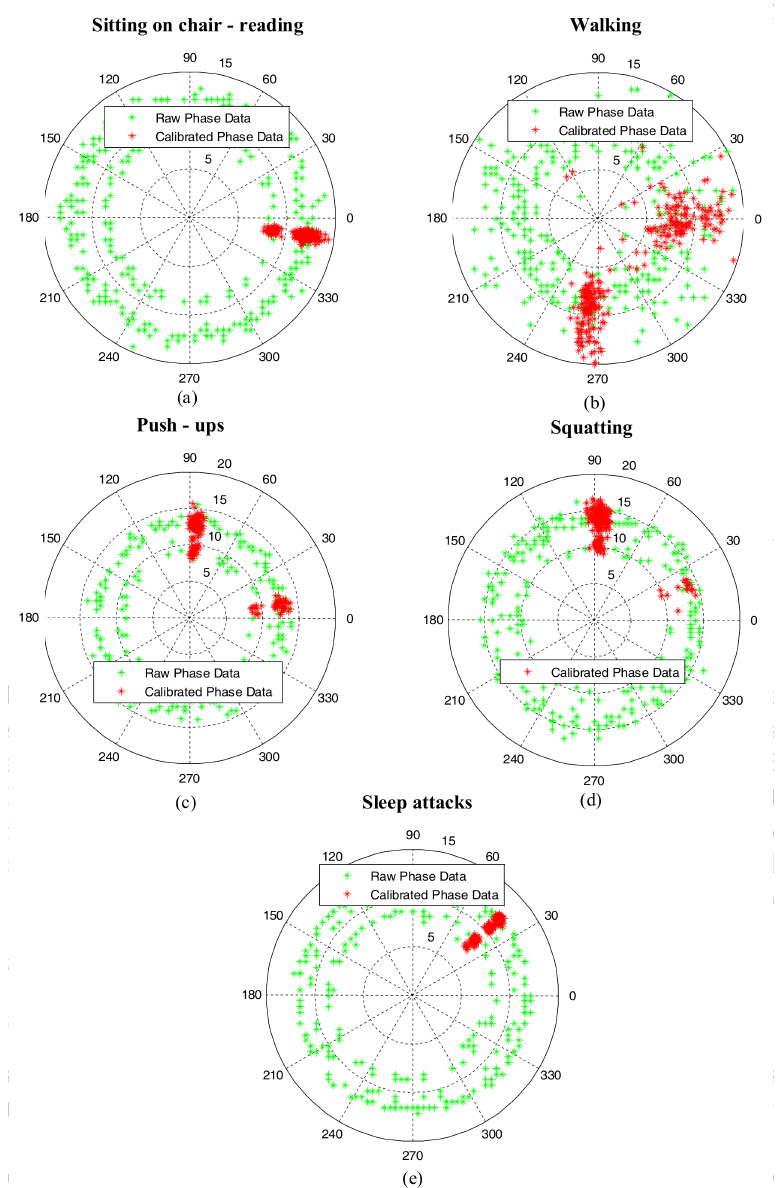
Figure 3. Raw channel information (CI) phase and calibrated phase information obtained during the